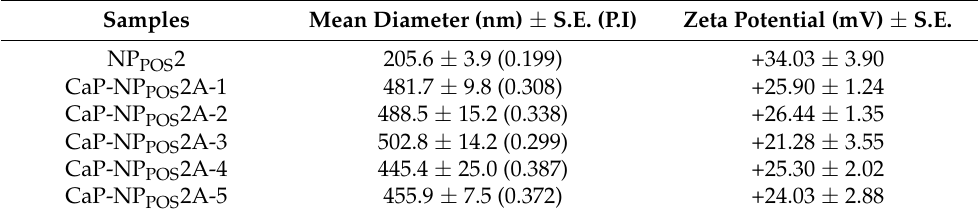
Table 4. Mean diameters and Zeta potential values of NP POS 2, uncoated and coated via method